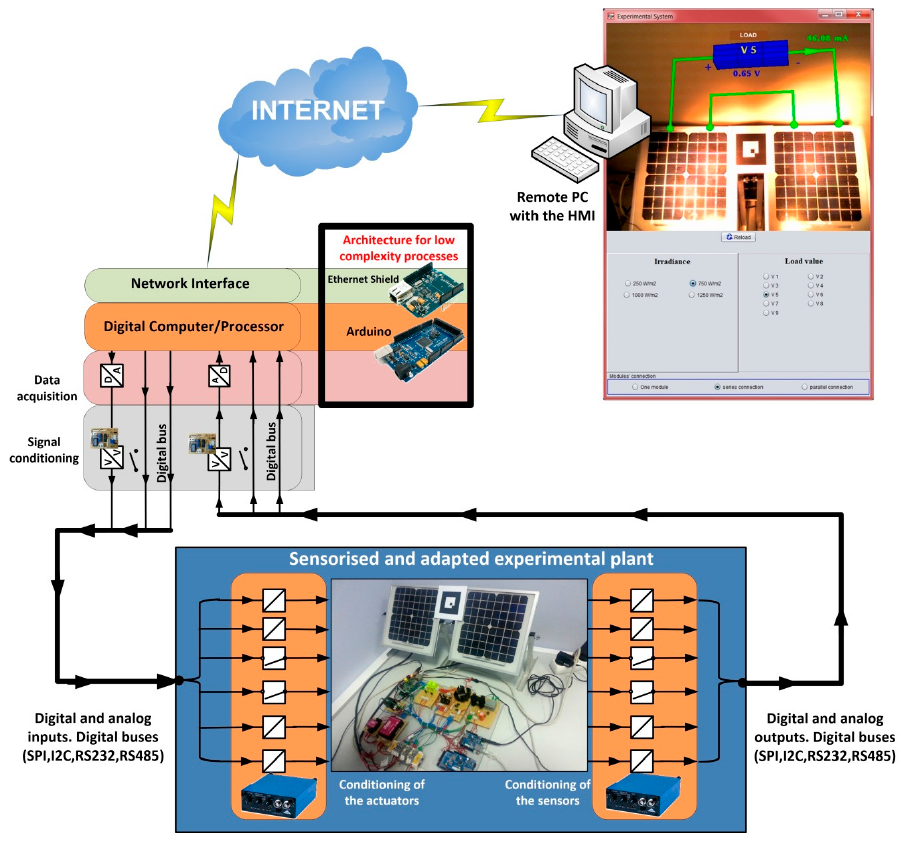
Figure 10. Layer structure of the convergence subsystem corresponding to the photovoltaic system.